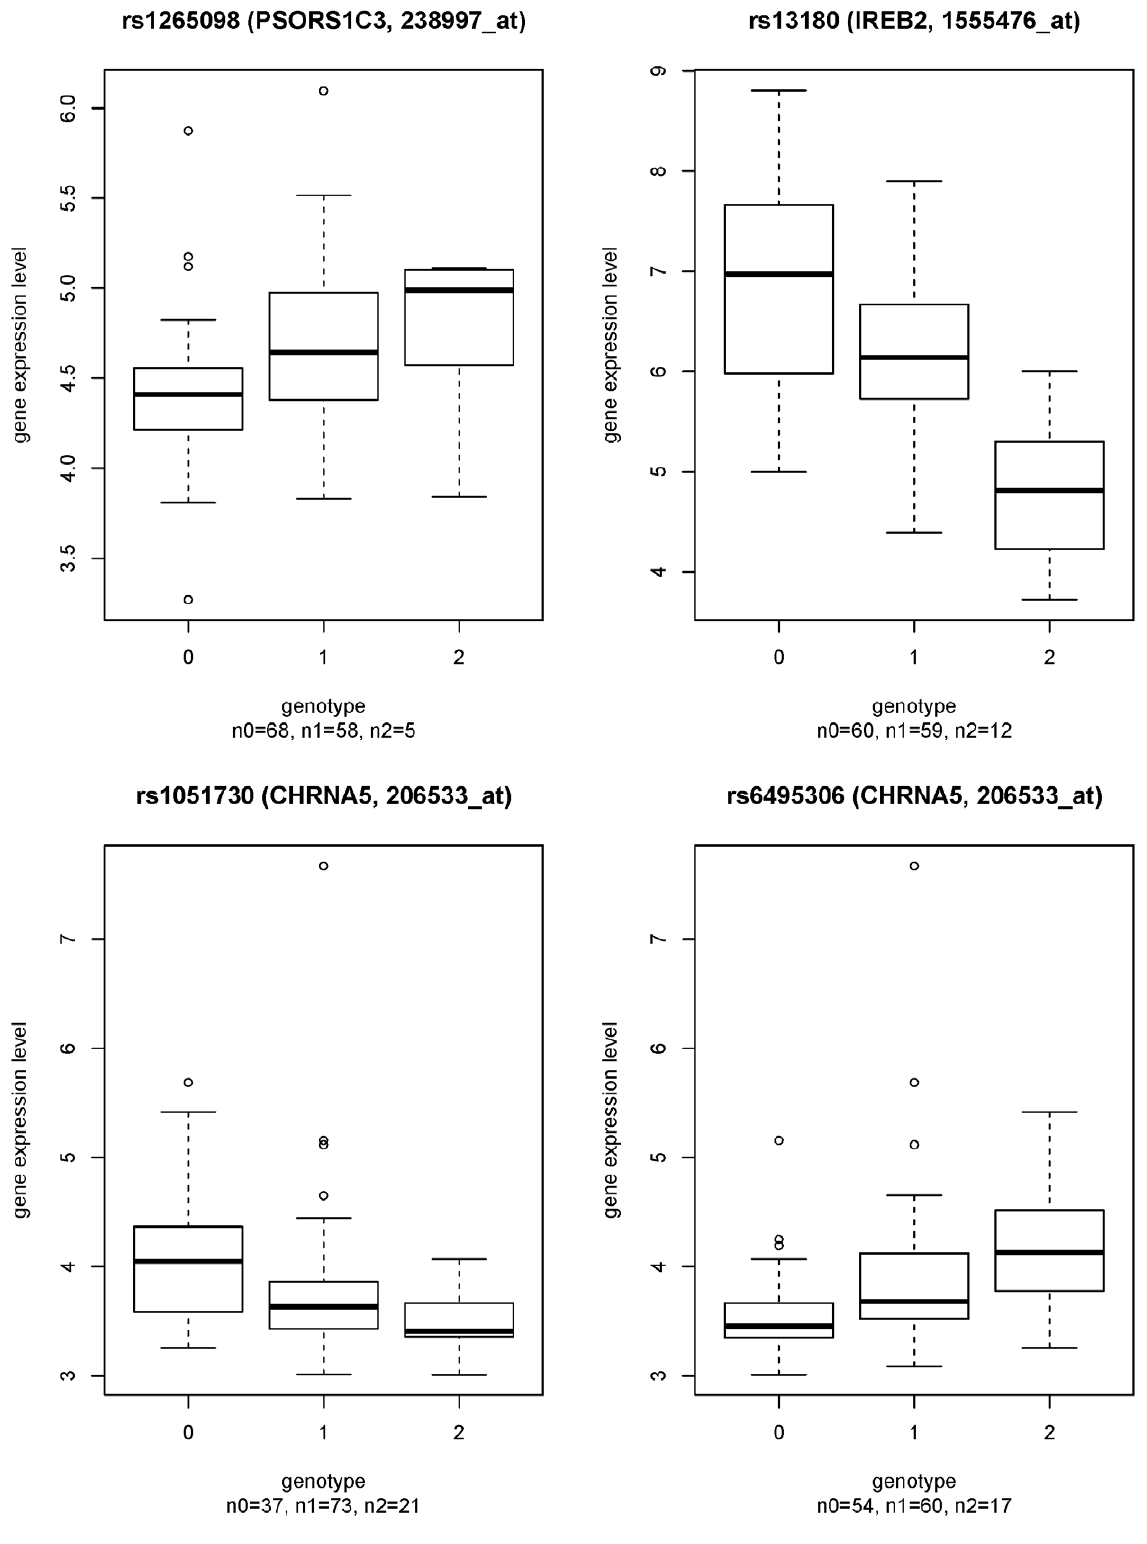
Figure 2. Boxplots of sputum gene expression levels stratified by genotype in 131 Evaluation of COPD Longitudinally to Identify Predictive Surrogate End-points (ECLIPSE) subjects with chronic obstructive pulmonary disease. a) rs1265098 - PSORS1C3 (238997_at), p=8.2e-5. b) rs13180 - IREB2 (1555476_at), p=6.7e-9. c) rs1051730 - CHRNA5 (206533_at), p=2.2e-4; LD bin 1 (see Table 4). d) rs6495306 - CHRNA5 (206533_at), p=9.9e-6; LD bin 3 (see Table 4).